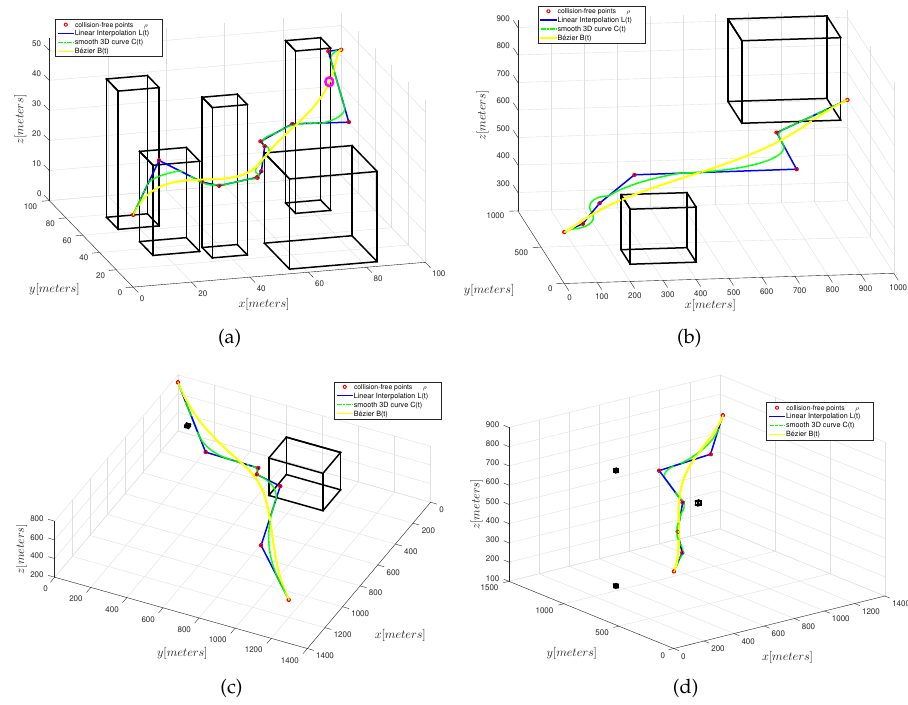
Figure 9. Additional 3D environment experiments in which the obstacles are the black boxes and the green line shows the final 3D trajectory CCC ( t ) ; the yellow line represents the Bézier B ( t ) curve. ( a ) (Table 1—Environment #1.) It represents an unstructured environment with different buildings, where a collision between B ( t ) and a building (collision marked as a circumference of magenta color) can be seen. ( b ) (Table 1—Environment #2.) 3D environment with two obstacles of ( d ) (Table 1—Environment #5.) 3D environment with three small aerial obstacles.